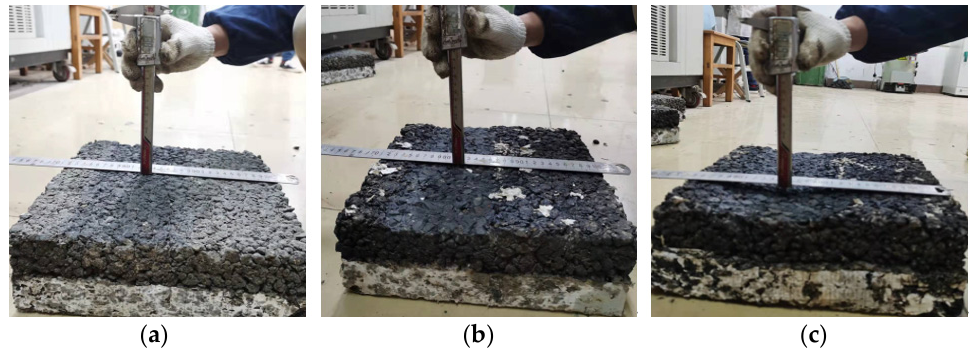
Figure 10. Images of the different pavement structures. ( a ) Structure- Ⅰ . ( b ) Structure-II. ( c ) Structure- Ⅲ .